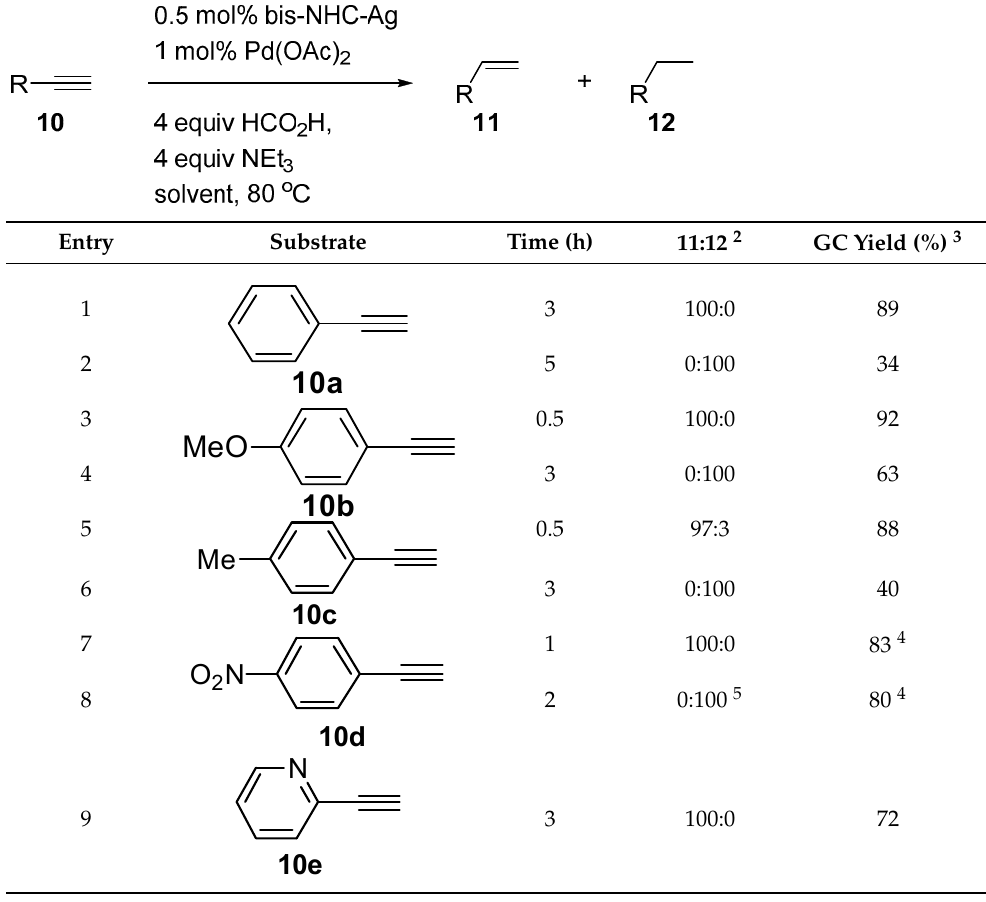
Table 5. Chemoselectivity studies for bis -NHC–Ag / Pd(OAc) 2 catalytic system catalyzed transfer hydrogenation of terminal alkynes in aqueous media 1 .